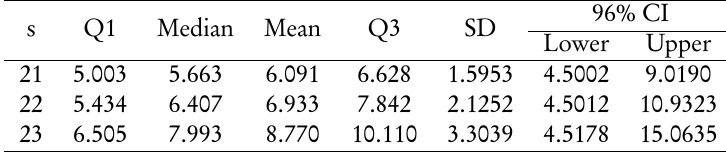
Sample based summary for one-sample predictive posterior based on Scheme 2 for real data